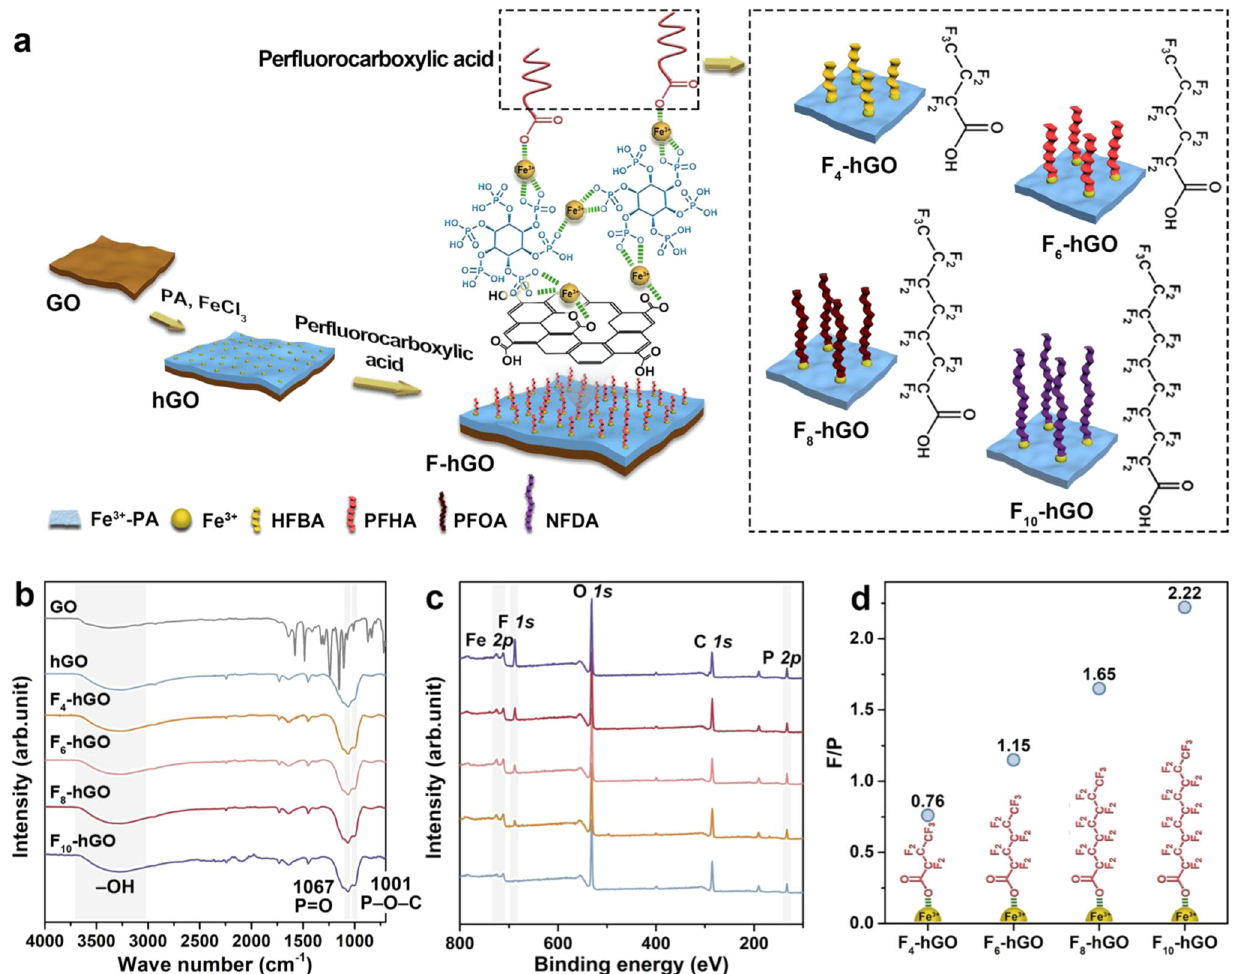
Fig. 1 | Preparation and structures of the membranes. a Schematic diagram of the fabrication of the F-hGO membranes. HFBA, PFHA, PFOA, and NFDA are hep- ta fl uorobutyric acid, per fl uorohexanoic acid, pentadeca fl uorooctanoic acid, and nonadeca fl uorodecanoic acid, respectively. b FTIR spectra of the GO, hGO, and